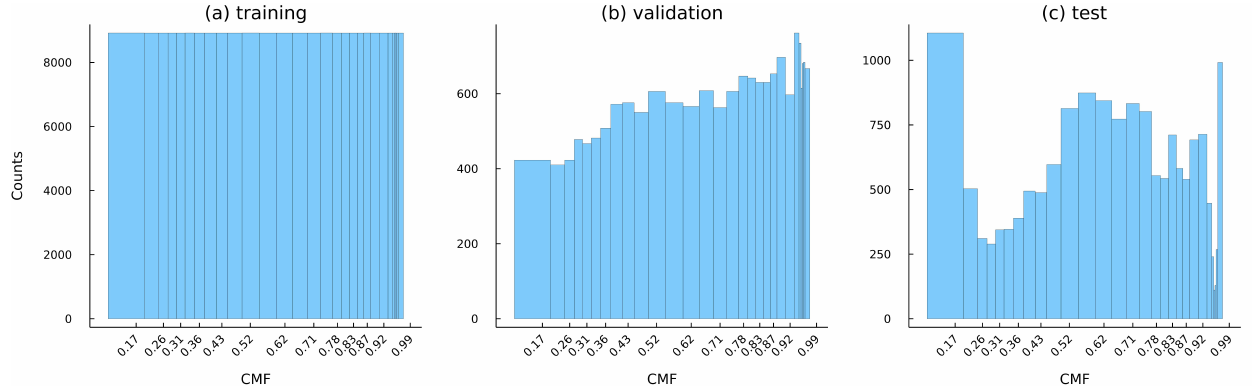
Figure 4. Distribution of CMF class for three data sets in Berlin: ( a ) training set for 2004–2018, ( b ) validation set for 2019, and ( c ) test set for